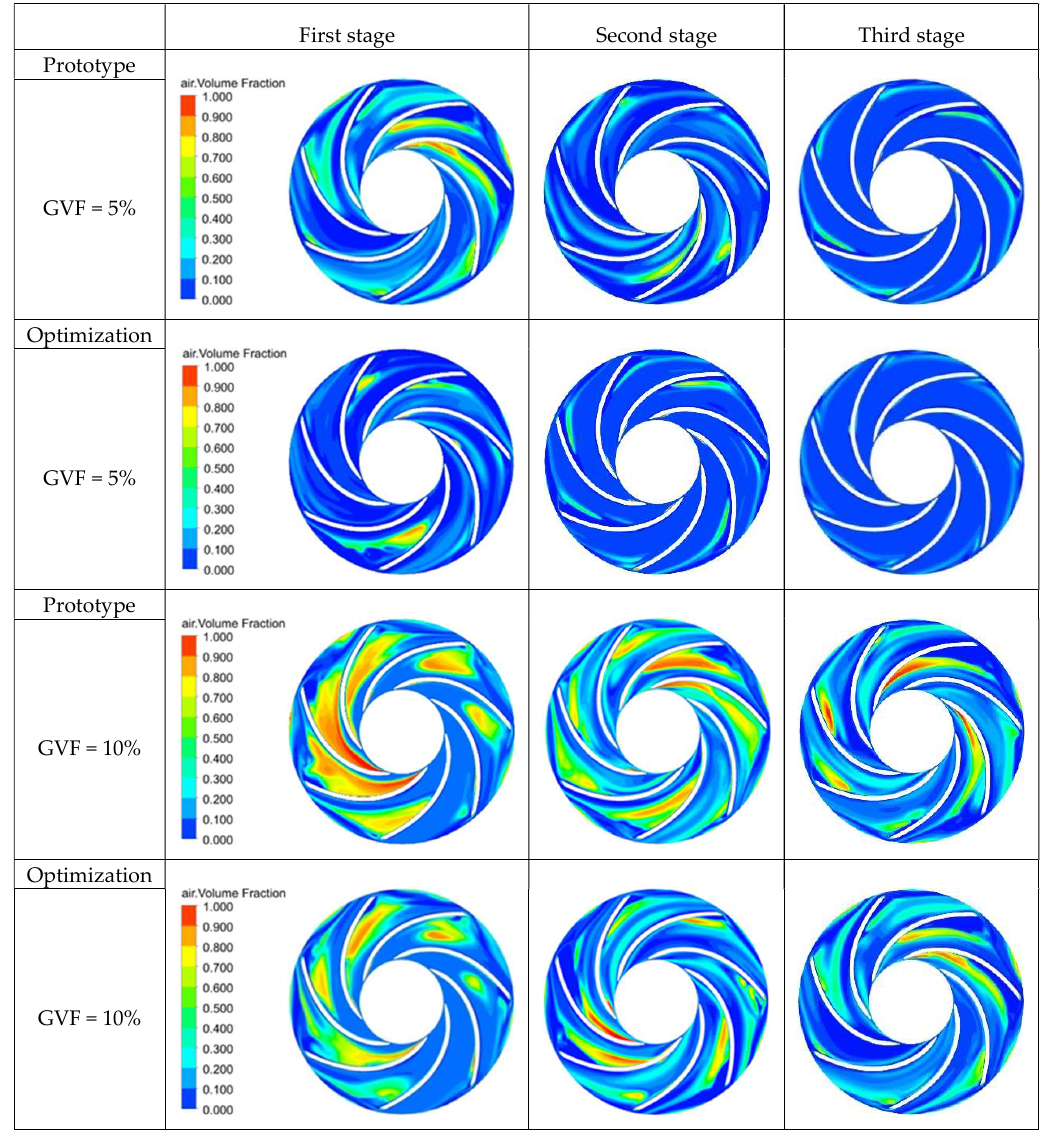
Figure 10. Gas distribution at different inlet gas volume fractions of each impeller.